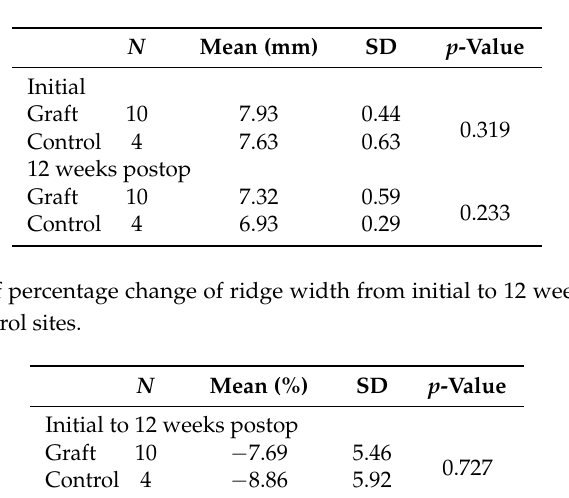
Table 1. Comparison of absolute values of alveolar ridge width between groups at each time point.